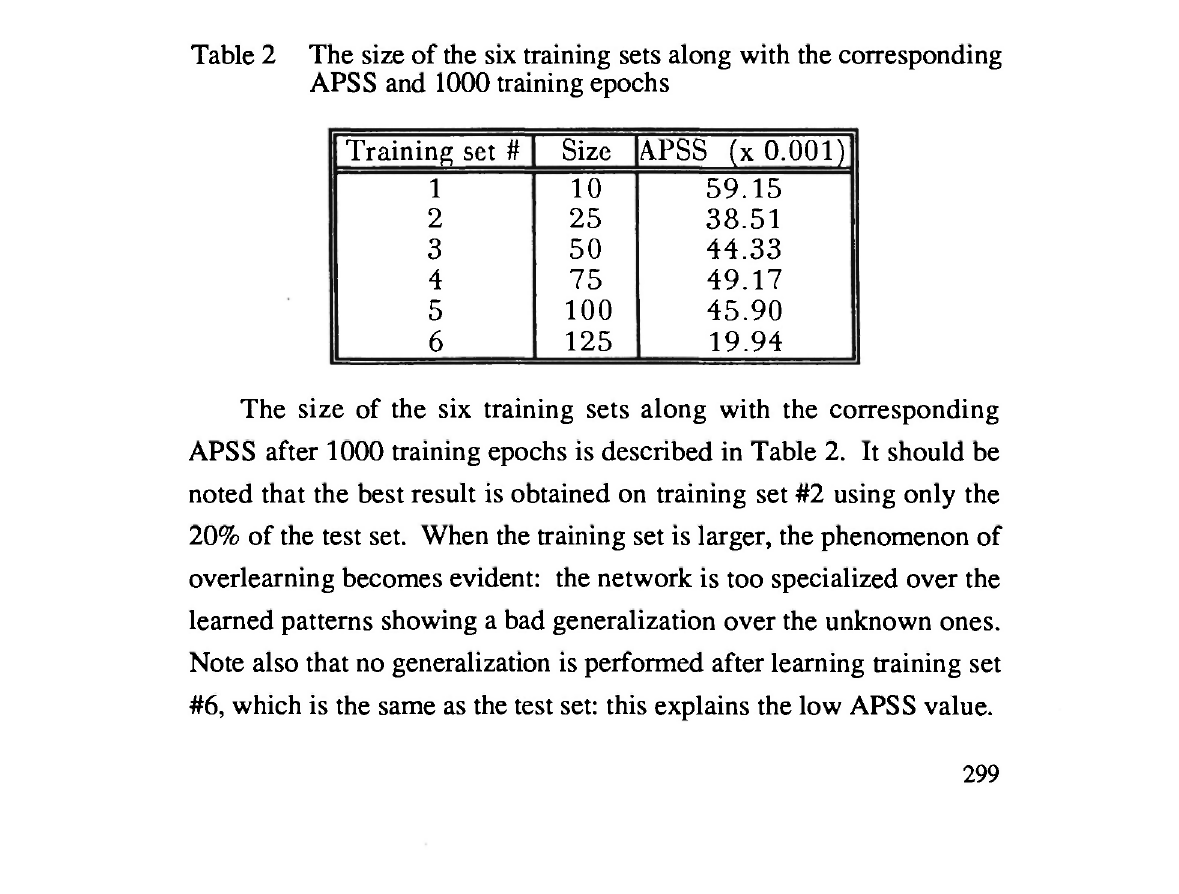
The size of the six training sets along with the corresponding APSS and 1000 training epochs Training set # Size APSS (x